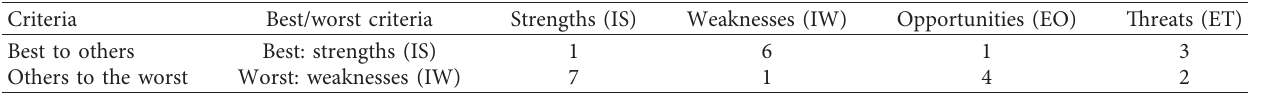
Table 4: Main criteria-pairwise comparison